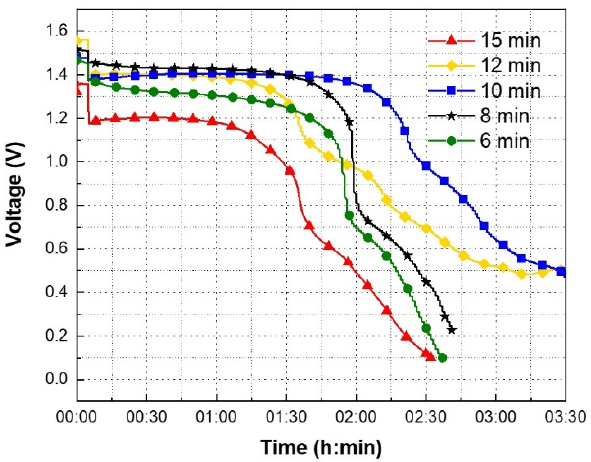
Figure 5. The discharge profiles of the printed batteries with 5 wt% PEO-based gel electrolyte dried at 40 °C for 6 min, 8 min, 10 min, 12 min and 15 min respectively.